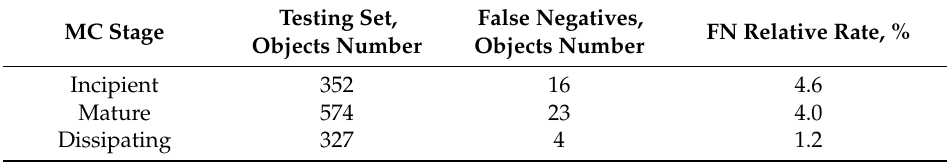
Table A4. False negative rates per MC